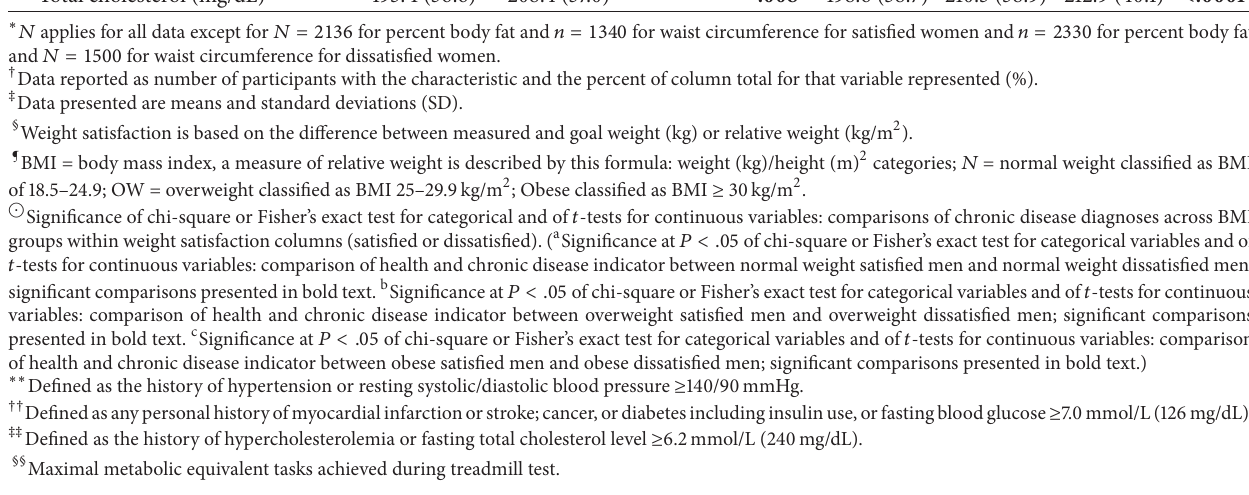
Satisfied (𝑛 = 2189) § Dissatisfied ( 𝑛 = 2406 ) Normal Normal Overweight Obese Overweight Obese 𝑃 ⨀ 𝑃 Weight ¶ Weight ( 𝑛 = 42 ) ( 𝑛 = 0 ) ( 𝑛 = 856 ) ( 𝑛 = 325 ) ( 𝑛 = 2147 ) ( 𝑛 = 1225 )